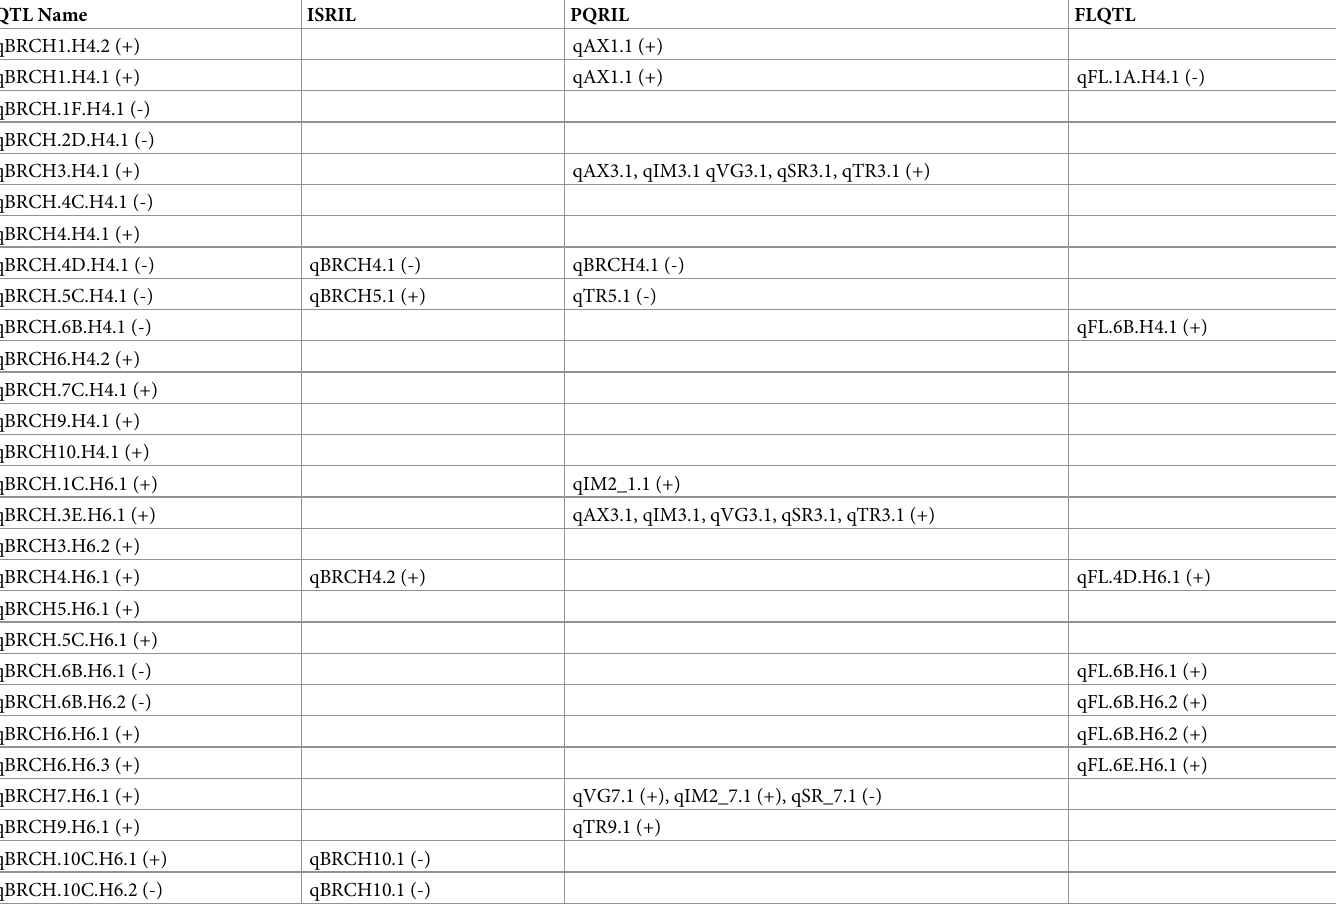
Table 4. Comparisons of BRCH QTL in SBSH-BC 1 F 2 , IS-RIL and PQ-RIL